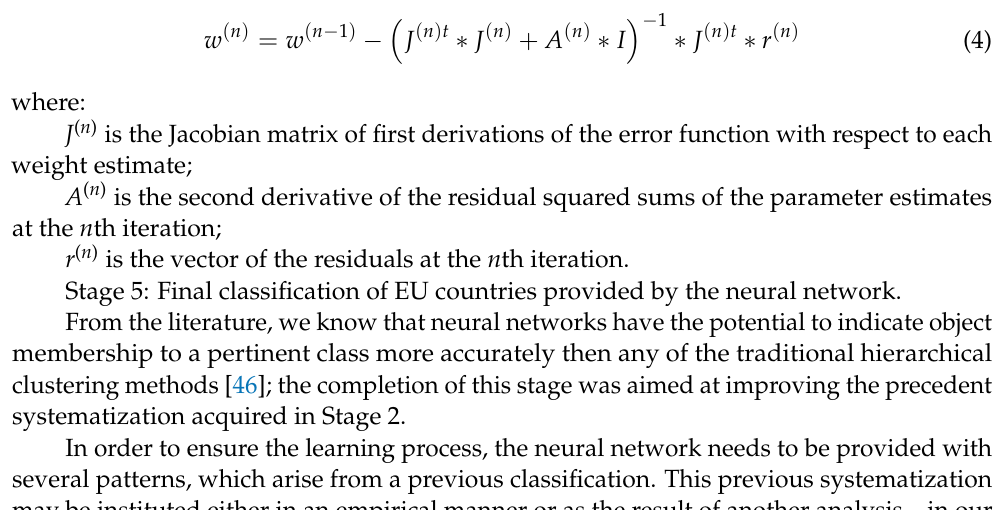
Stage 5: Final classification of EU countries provided by the neural